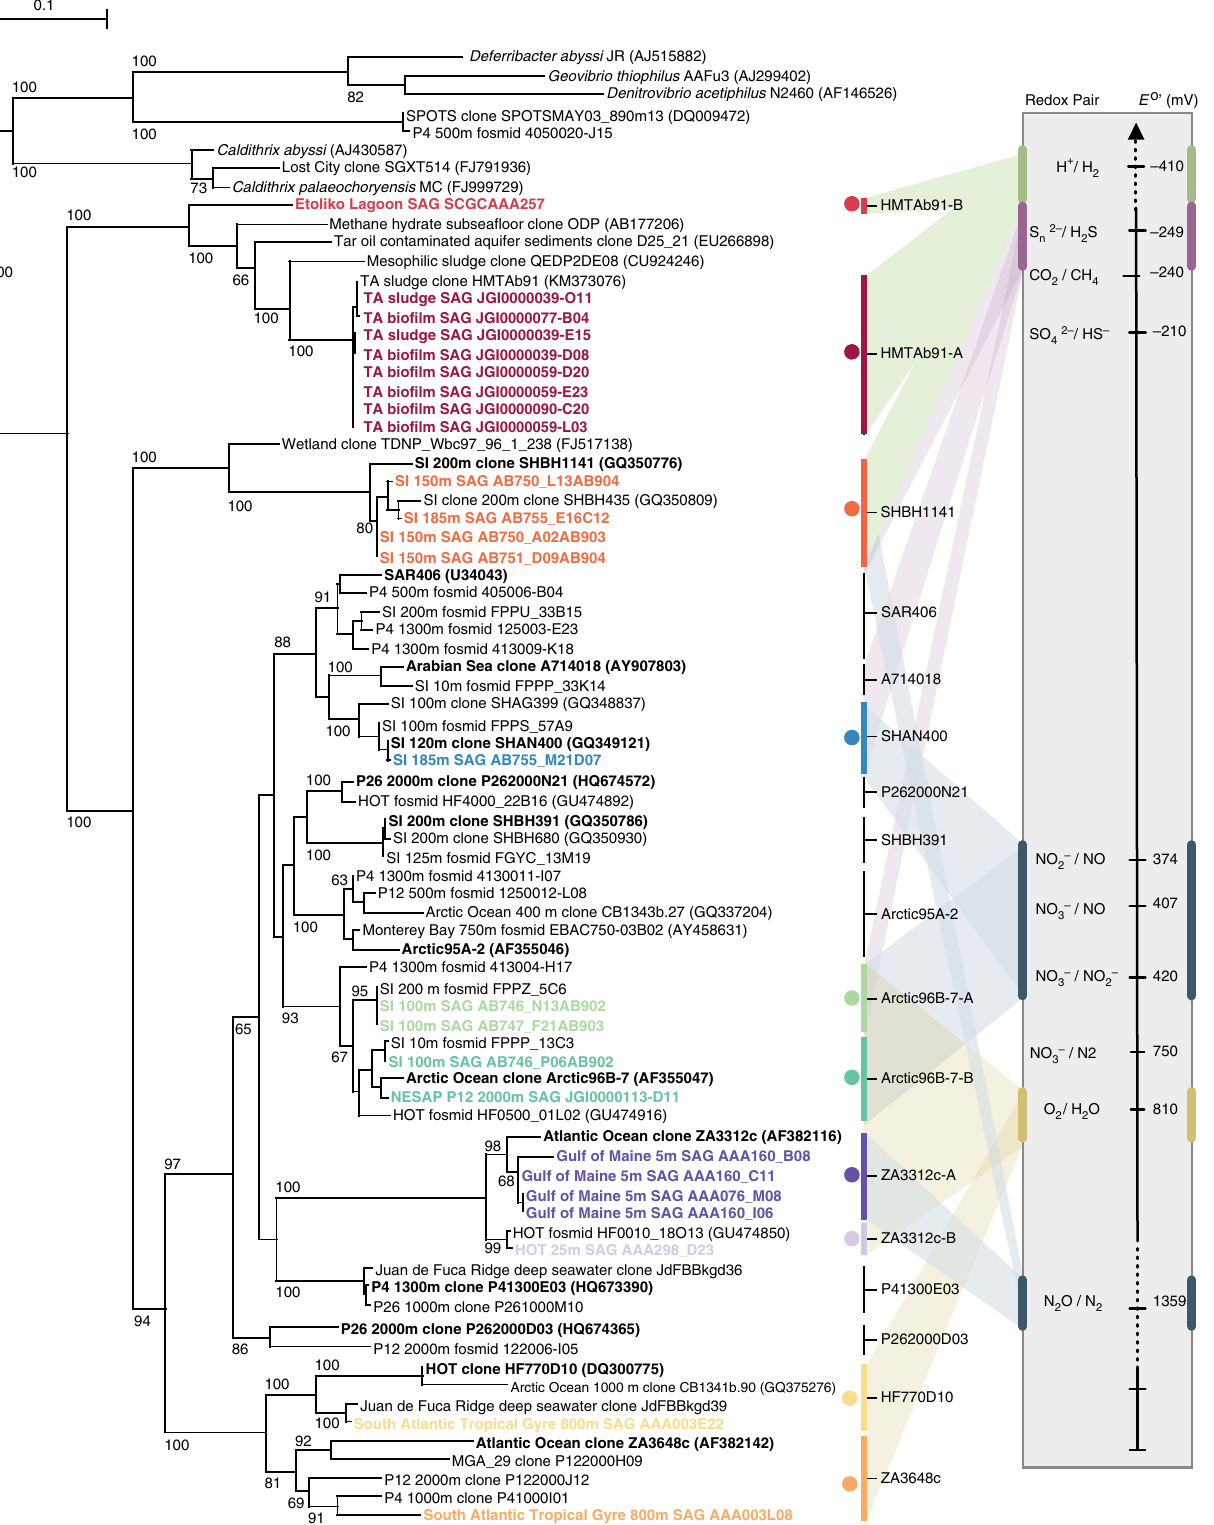
Fig. 1 Maximum-likelihood small subunit rRNA gene tree and proposed energy metabolism for Marinimicrobia clades. Maximum likelihood phylogenetic tree of small subunit ribosomal rRNA (SSU rRNA) genes from all available studies. SSU rRNA genes from SAGs used in this study are in bold and colored to indicate there membership to population genome bins. Redox pairs are colored consistent with Fig. 1. Energy metabolism redox pairs for each clade explored in this publication are mapped to the electron tower on the right of the tree. The bar represents 1% estimated sequence divergence. Bootstrap values below 50% are not